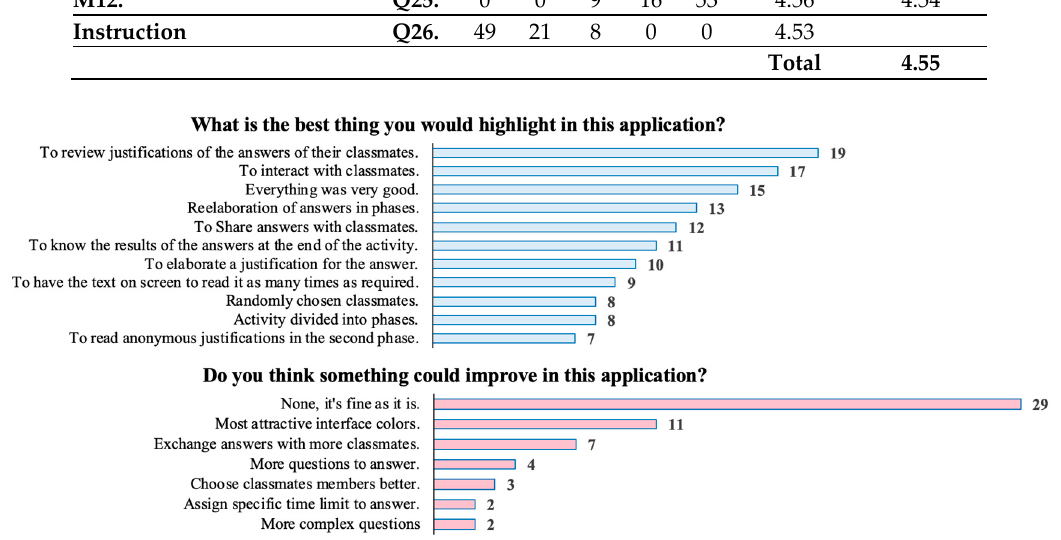
Figure 2. Responses to open-ended questions. We counted a total of 129 aspects to highlight because of the frequency students mentioned them, which were grouped in 11 categories and 58 aspects to improve, which whose frequencies were categorized in 7